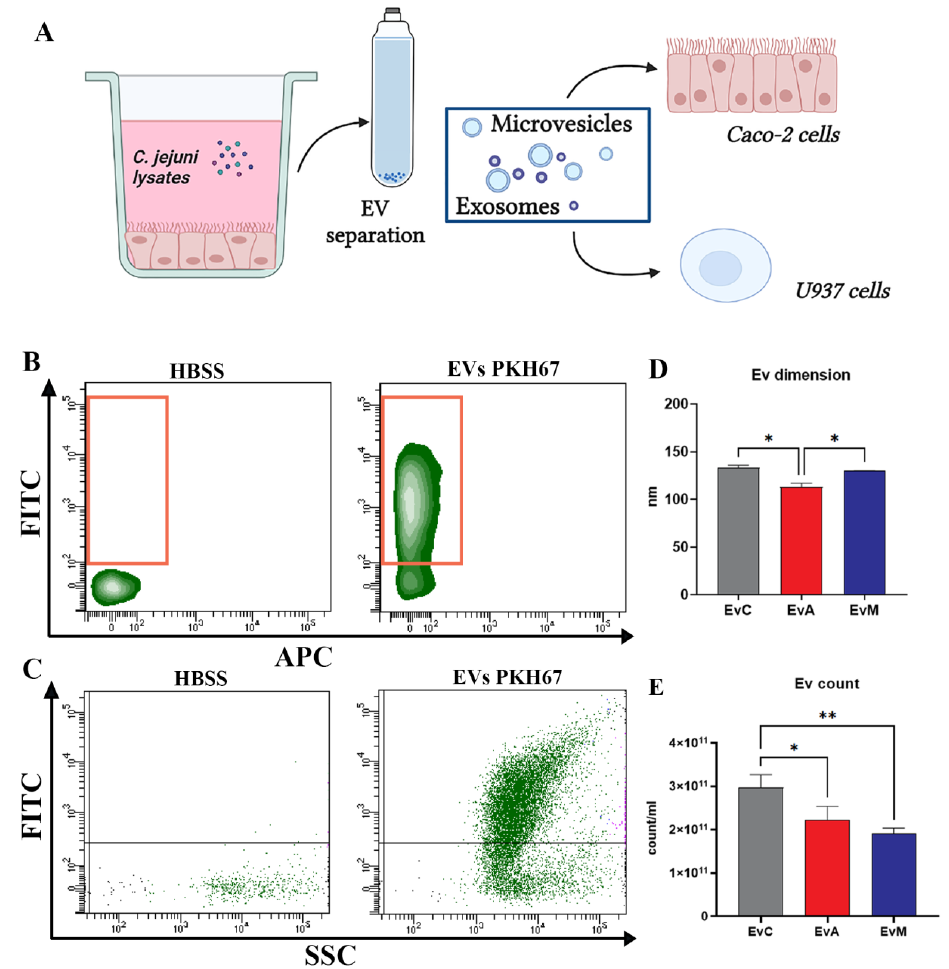
Figure 5. ( A ) Schematic of EV separation by ultracentrifugation and EV administration to the uninfected Caco-2 and U937 cells (created in Biorender.com). ( B ) Density plot FITC vs. APC of the HBSS and PKH67-labeled EVs. ( C ) Dot plot FITC vs. SSC of the HBSS and PKH67-labelled EVs. ( D ) Statistical histogram for the size distribution for EvC, EvA, and EvM. ( E ) Statistical histogram for the particle concentration for EvC, EvA, and EvM. One-way ANOVA with Bonferroni’s multiple comparison test. The asterisk denotes a statistically significant difference (* = p < 0.05, ** = p < 0.01). incubated with 2 × 10 4 PKH67-labeled EVs/cell for 48 h and analysed by FC and CM (Fig- in apoptotic cells in both the Caco-2 and U937 cell lines (Figure 6A,B). Our data high- lighted a similar EV uptake for EvC and EvA for the Caco-2 cells, whereas EvM appeared